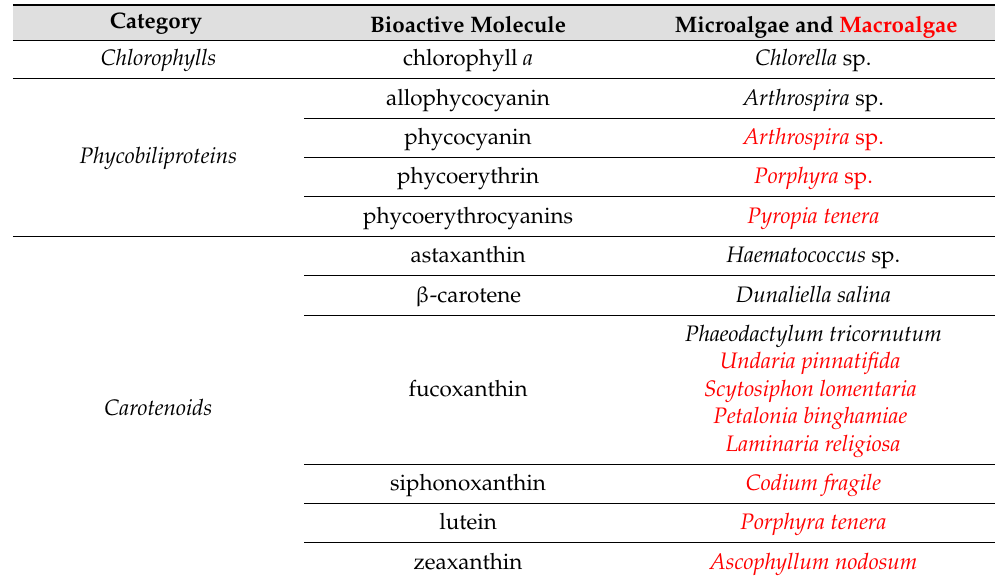
Table 1. Example of some bioactive compounds present in micro and macroalgae (in red). References are indicated only for the algae and corresponding bioactive molecules not cited in the text. When the species is lacking, it is because the reference does not give an indication of the